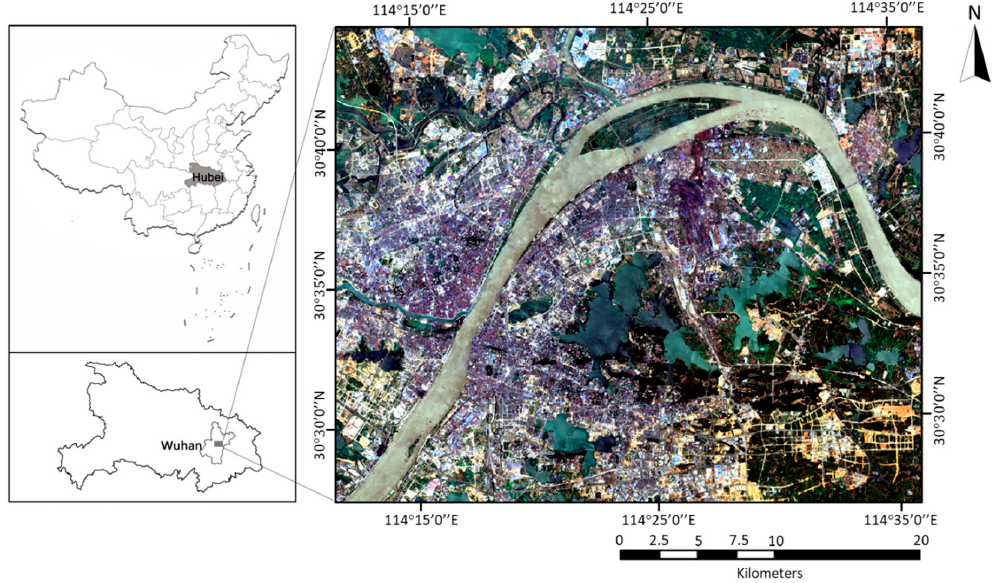
Figure 1. The study area represented by the Landsat 8 image (RGB) acquired on 16 August